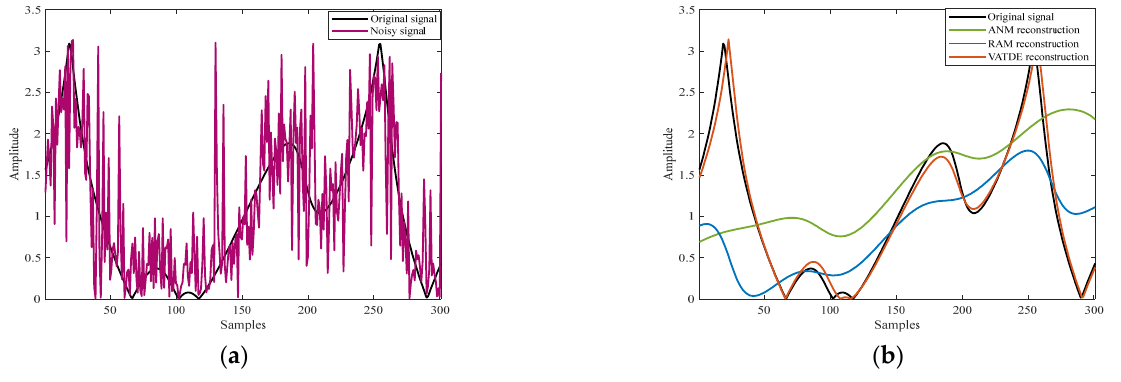
Figure 3. Multiple time delay estimation performance of different algorithms with an SNR of 10 dB.